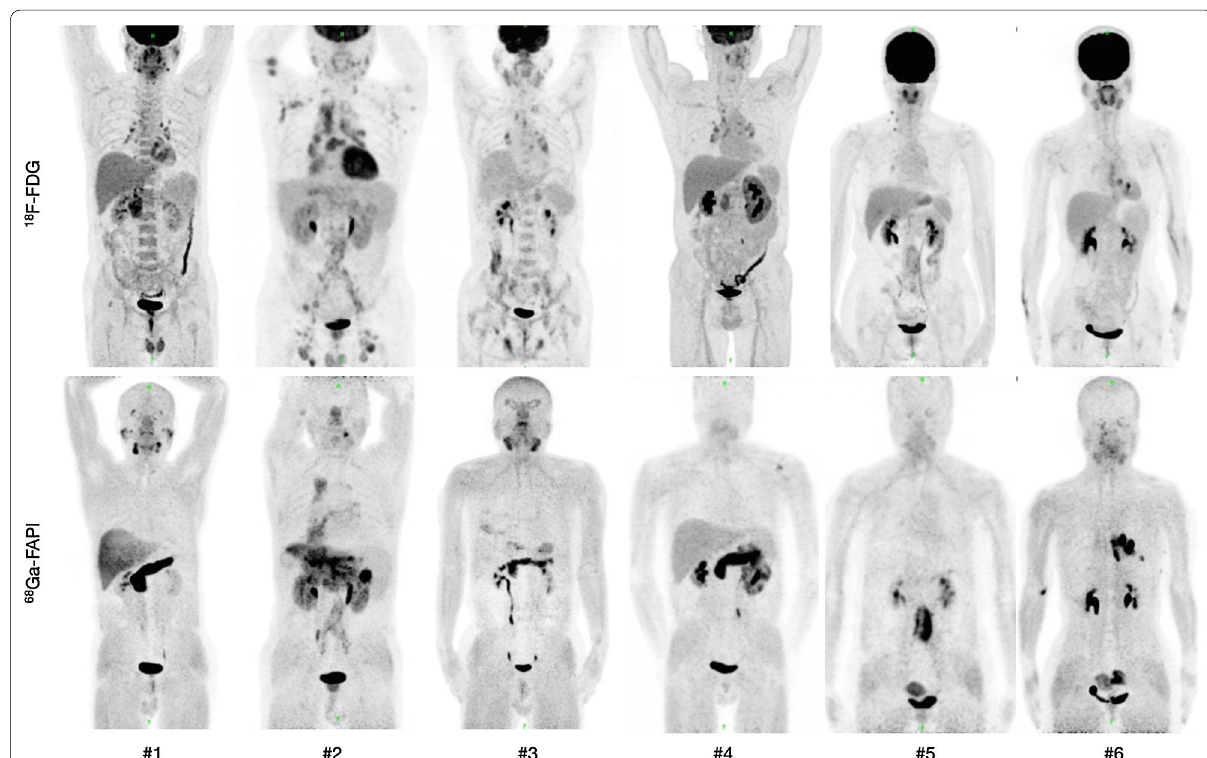
Fig. 2 Comparison of 6 patients with IgG 4 -related disease (IgG 4 -RD) undergoing FDG and FAP-specific PET. FAP-specific PET detected IgG 4 -RD in the pancreas (patient #1, 2, 3, 4) bile duct/liver (patient #1, 2, 3), retroperitoneal fibrosis (patient #5), lung/pleura (patient #6), and salivary gland (patient #1, 3). Positive Iymph nodes on FDG PET show no enhancement on FAP-specific PET (patient #2, 3) (Fig. 2). This research was originally published in JNM. Luo et al. Fibroblast activation protein targeted PET/CT with 68 Ga-FAPI for imaging IgG 4 -related disease: comparison to 18 F-FDG PET/CT. J